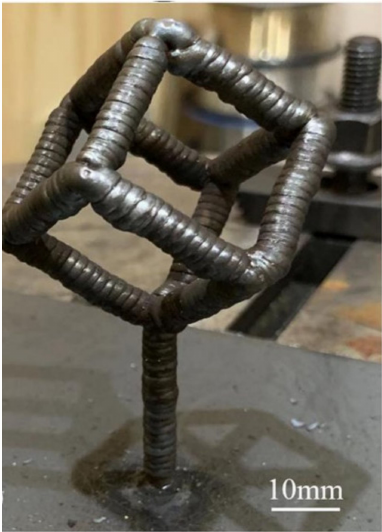
Figure 9. An example of skeleton WAAM